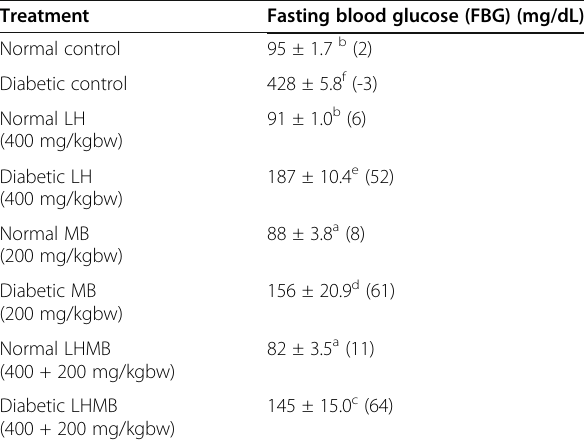
Table 1 Percentage decrease in fasting blood glucose (FBG) of normal and STZ-induced diabetic rats treated with aqueous leaf extracts of L. hastata and/or M. balsamina for 4 weeks Treatment Fasting blood glucose (FBG)